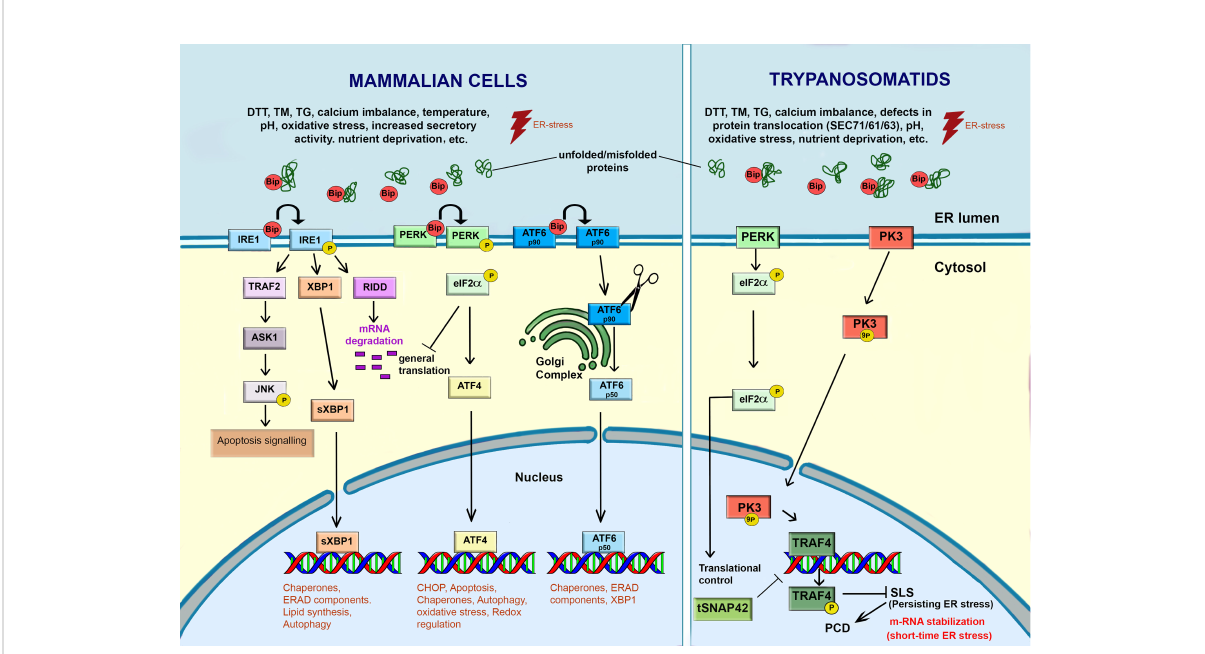
FIGURE 4 Response to ER-stress in mammalian cells and trypanosomatids. In mammalian cells, the accumulation of unfolded or misfolded proteins, induced by various intrinsic and extrinsic stimulus, causes ER stress. Under stress, BiP/GRP78 dissociates from the ER transmembrane stress sensors (IRE1, PERK and ATF6) and activates a signaling cascade to re-establish the ER functions and promote cell survival through the transcription of genes related to autophagy, chaperones, lipid biosynthesis, ERAD, etc. However, failure of this adaptative UPR response may activate programmed cell death (PCD). Trypanosomatids lack a canonical UPR response. IRE1 and ATF6 are absent in these parasites. A PERK homologue was found in Leishmania spp. and T. cruzi . In Leishmania spp., ER-stressors activate PERK, which in turn phosphorylates eIF2 a . The phosphorylation of eIF2 a leads to attenuation of translation and a decrease in the load of proteins into the ER. In Trypanosoma brucei , PK3, a serine threonine kinase, plays a key role in sensing and transmitting the ER-stress signal from ER to the nucleus, where it activates the Splice Leader Silencing (SLS) pathway. PK3 phosphorylates TRF4, causing its release from its cognate promoter. The hallmarks of SLS are the shut-off in SL RNA due to impairment of tSNAP42 ’ s ability to bind the SL RNA promoter, leading to its accumulation in the nucleus. Under mild ER- stress, some mRNAs are stabilized. When the ER-stress is persistent, the PK3-TRAF4-SLS cascade leads to the cell death. This freehand digital illustration was made using Procreate ® and Adobe Photoshop ®